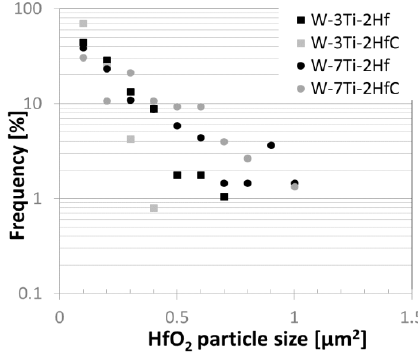
Figure 6. Frequency plot of HfO 2 (HfTiO 4 ) particle sizes.